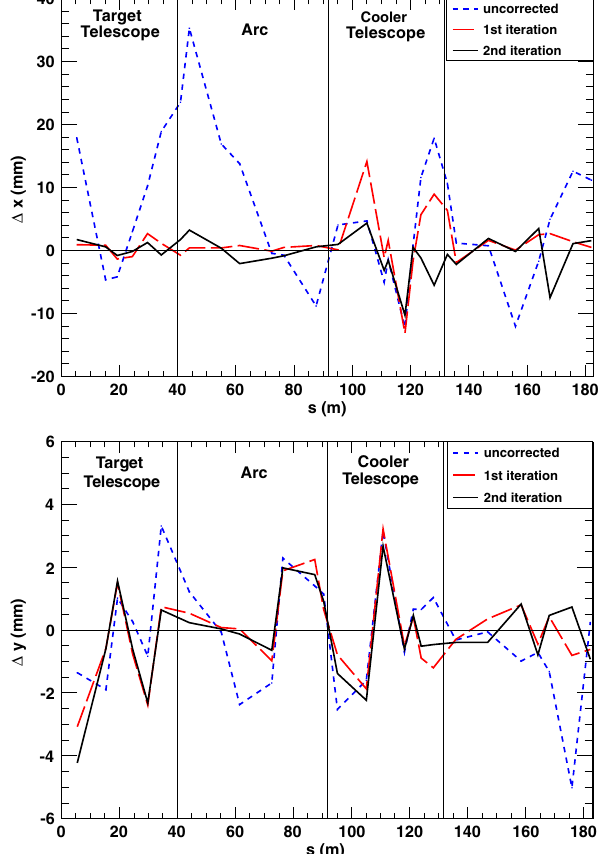
FIG. 13. Effect of horizontal (top) and vertical (bottom) closed orbit correction for COSY at injection energy ( T The initial vertical orbit deviations are in general smaller than the horizontal ones.